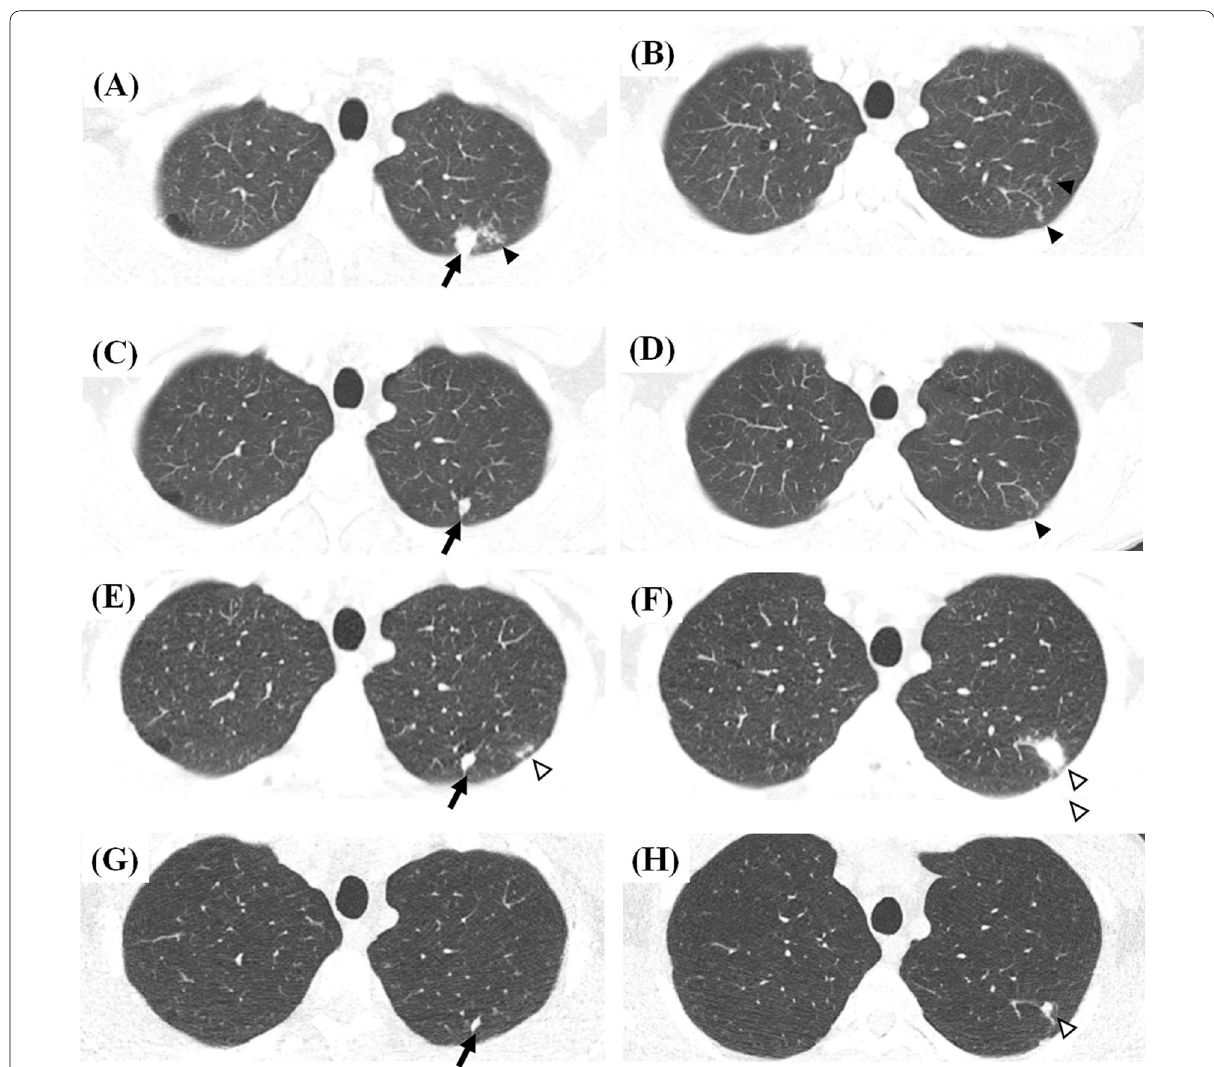
Fig. 1 Representative CT images showing dynamics of recent tuberculosis infection in a 33‑year‑old male contact of a patient with infectious multi‑drug resistant tuberculosis. a , b Baseline CT images show a nodular consolidation (black arrow) and micronodules (black arrowhead) in two secondary pulmonary lobules in the apicoposterior segment of the left upper lobe ( a ). Another minimal pauci‑nodular infiltration is noted in the adjacent subsegmental lobules (black arrowhead) ( b ). Bacteriologic/molecular tests of bronchoscopic alveolar lavage fluid were negative. The patient was observed without treatment. c , d Decreases in the previous pauci‑nodular infiltrations are shown on follow‑up CT images 14 months after the baseline CT examination. Sputum smear and culture were negative. e , f Eighteen‑month follow‑up CT images show new nodular consolidation and adjacent pauci‑nodular infiltrations (white arrowheads) from one of the shrunken nodules ( e , f ), while another nodule remains stable (black arrow) ( e ; variable changes among lesions within a host). The close contact denied any symptoms and signs. Bacteriologic/molecular tests of bronchoscopic alveolar lavage fluid were negative. However, radiologic progression was regarded as indicating active tuberculosis, leading to the subsequent initiation of anti‑multidrug resistant tuberculosis treatment. g , h Follow‑up CT images 5 months after treatment show decreases in the previous nodular lesions with a few residual small nodules (black arrow and white